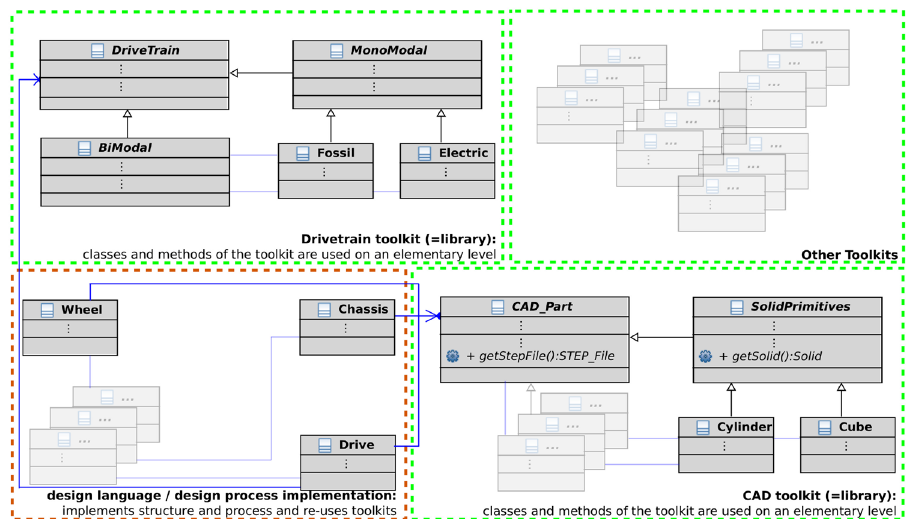
Fig. 18 Modeling the product structure and design process in a central design language. External toolkits for special purposes are embedded on an elementary level (single classes and methods) to re-use existing engineering solutions (toolkits=engineering